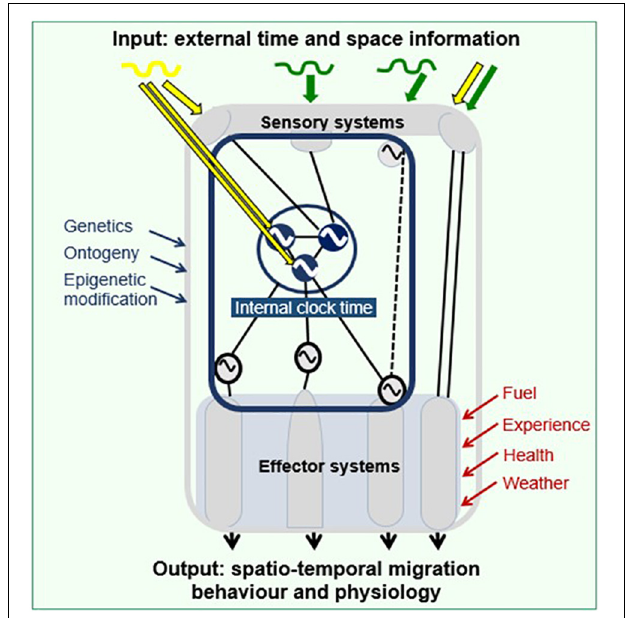
FIGURE 4 | Mechanistic framework of spatio-temporal migration programs. Gray frame delineates the organism. It receives spatio-temporal information from the geophysical (yellow) and the biotic (green) environment, perceived through its sensory systems. This information is integrated with the animal’s biological clock (blue) to generate internal clock time. Clock time modulates effector systems, which integrate additional modifying information (red) from within the body (e.g., fuel reserves) and from the environment (e.g., weather), to set the spatio-temporal migration behavior and physiology. Oscillator symbols indicate biological rhythms (central clock in inner circle, additional clock components peripheral). The clock system is itself modified by different factors (blue); for details see Helm et al.